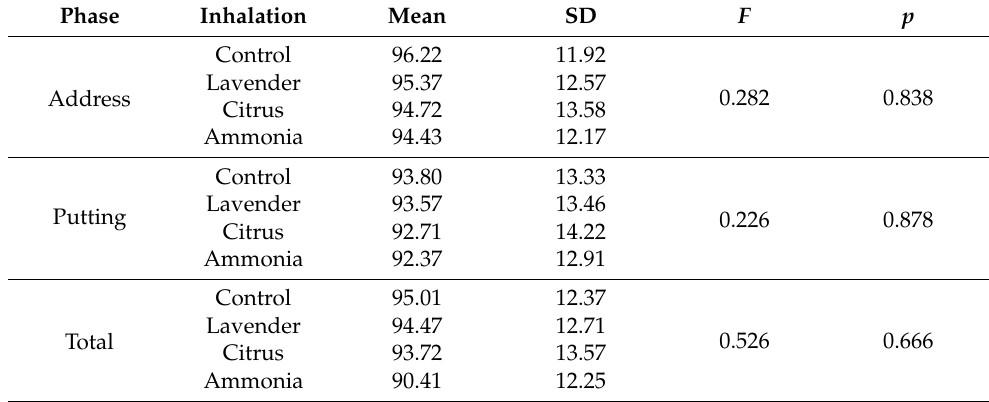
Table 4. Heart rate according to olfactory inhalation ( n =